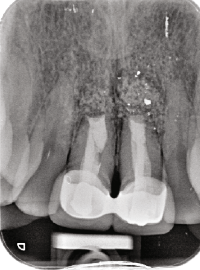
Figure 20: Periapical radiograph one month after surgery: correct retrograde cavity preparation is observed.